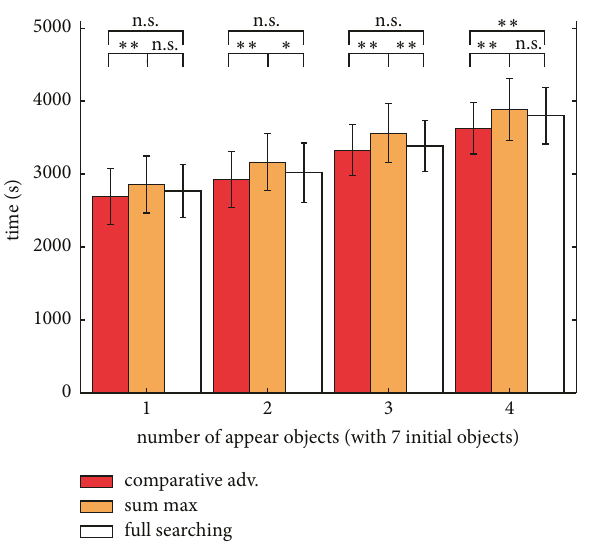
Figure 16: Makespan in the speed-up condition. (1/10 carrying speed condition). ∗∗ 𝑝 < .01 , ∗ 𝑝 < .05 , and + 𝑝 < .1 . A significant 𝑝 value indicates that a significant difference in prescribing exists between the conditions. The lower 𝑝 value indicates a strong significant difference. n.s. means no significant difference between the conditions.